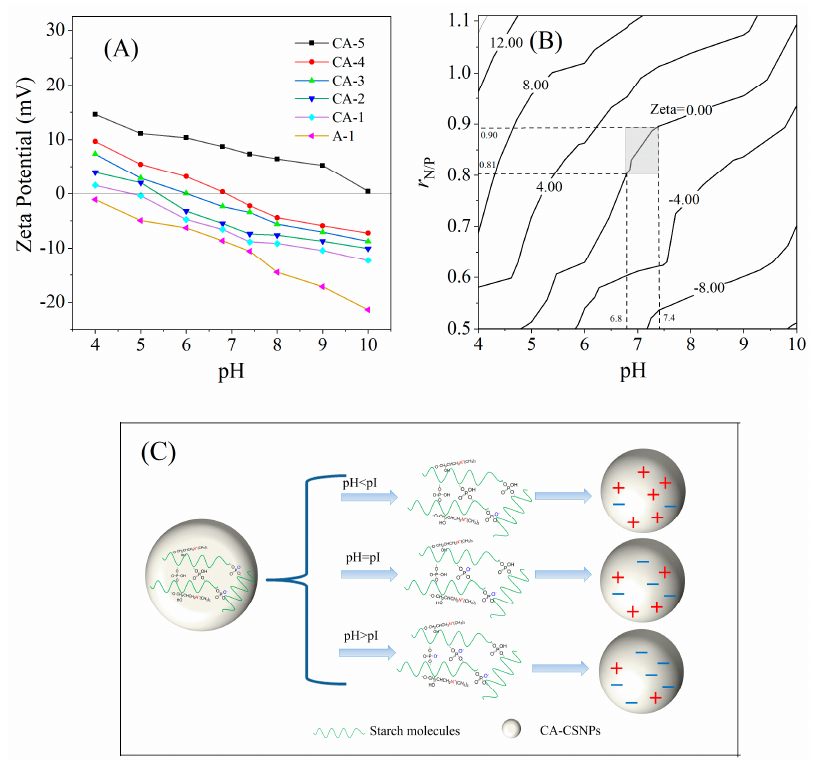
Figure 5. Effects of solution pH and the N/P ratio on the zeta potential ( A ) and isopotential map ( B ) of CA ‐ CSNPs and the charge ‐ reversal mechanism on CA ‐ CSNPs ( C ) . Table 2. Effects of CHPTAC amount on the content of nitrogen and phosphorus, rN/P, and pI of CA ‐ CSNPs.